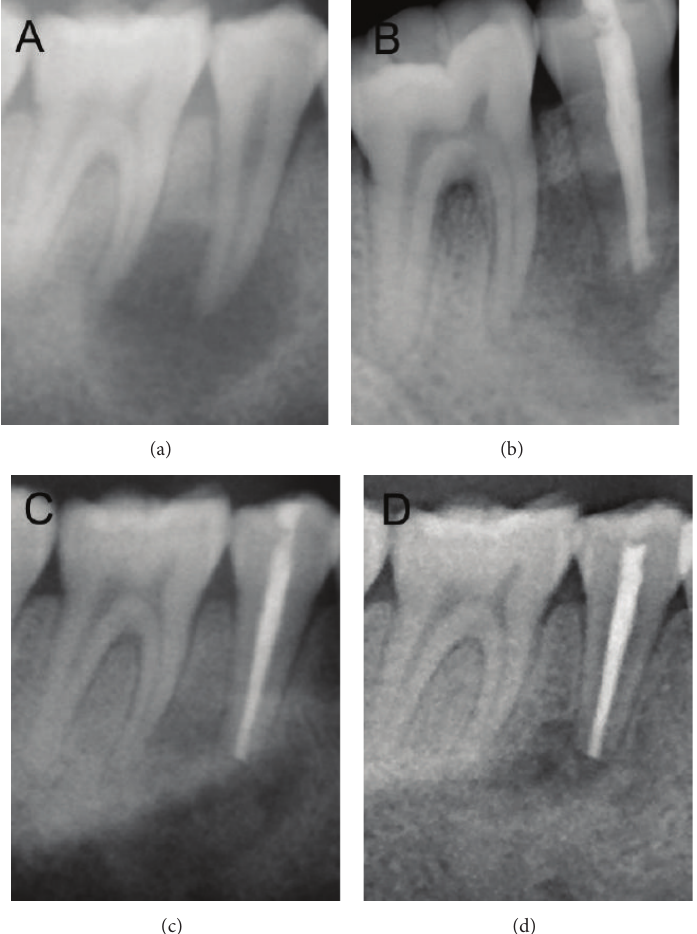
Figure 2: Radiographs. (a) Radiograph at the initial visit showing a large periapical lesion associated with tooth 45, measuring 14 × 15mm in diameter. (b) A periapical radiograph of tooth 29 and tooth 30 to observe and record the immediate postoperative situation. (c) Radiograph after 3 months showing a decrease in the size of the periapical radiolucency to 13 × 14 mm in diameter and some material implanted seemed to be absorbed. (d) Radiograph after 7 months showing an apparent decrease in the size of the radiolucent area to 4 × 5 mm in